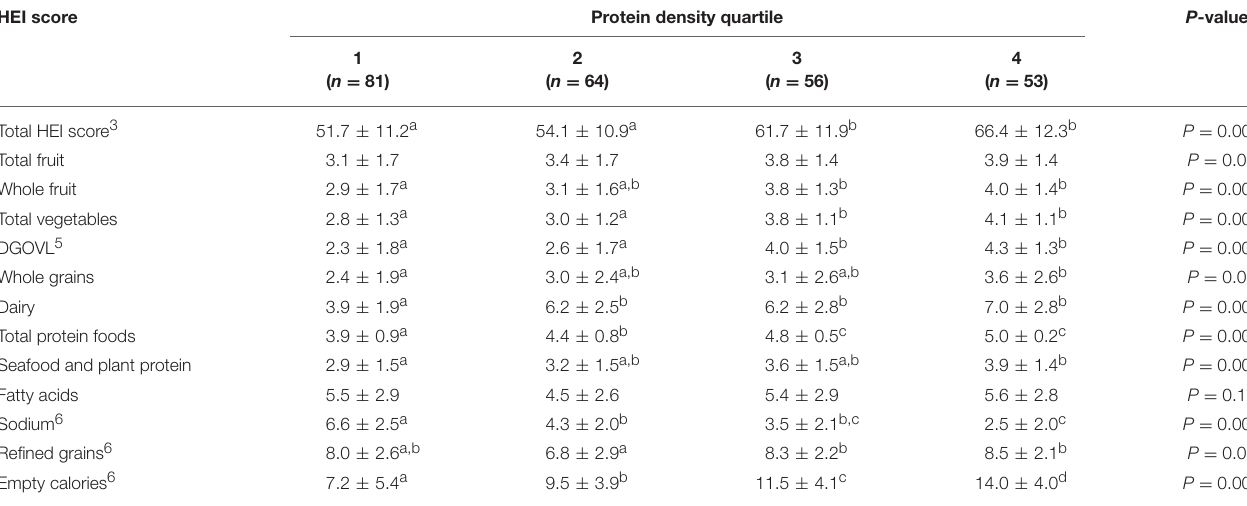
TABLE 3 | Healthy Eating Index (HEI) scores based on habitual protein intake in healthy young females 1, 2 . HEI score Protein density